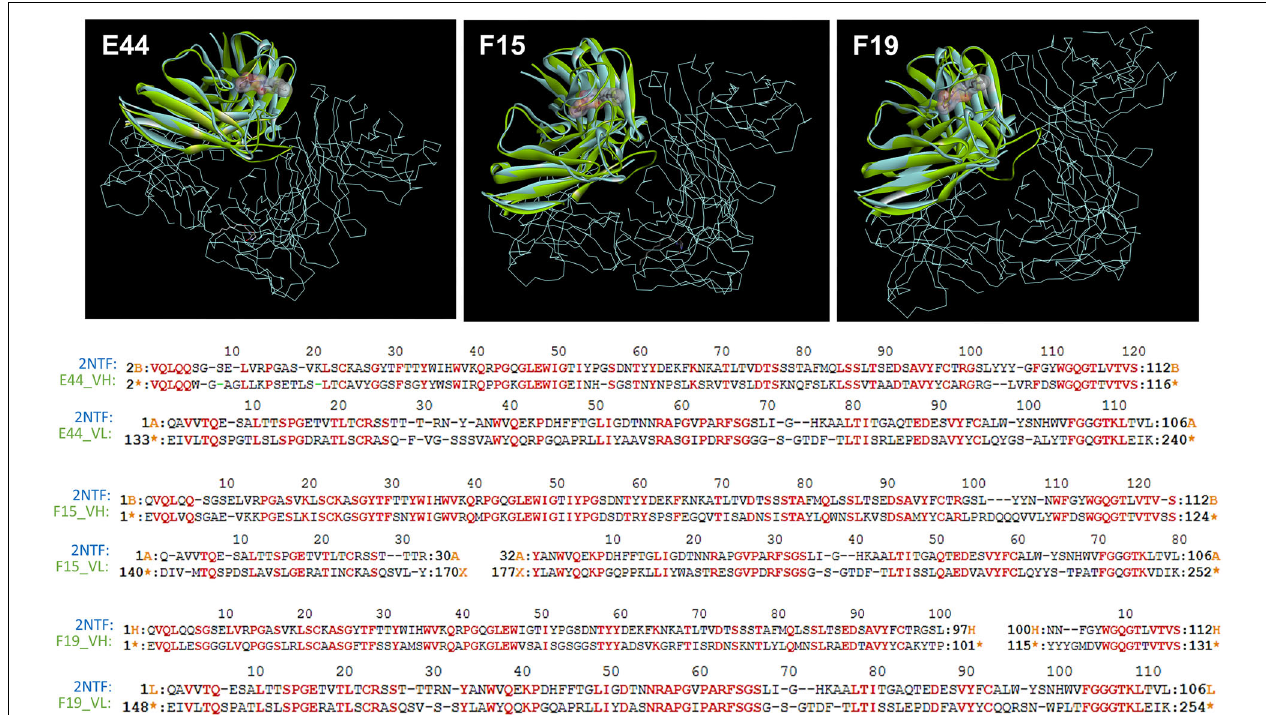
FIGURE 1 | The 3D complex of RS2-1G9 F(ab (cid:48) ) 2 fragment and N -Acyl- L -homoserine lactone analog (PDB:2NTF) was superimposed by the HuscFv-E44 (left), HuscFv-F15 (middle), and HuscFv-F19 (right) using CLICK: http://mspc.bii.a-star.edu.sg/click (Upper panel) . One antigen-binding site of the mAb RS2-1G9 F(ab (cid:48) ) 2 fragment (VH and VL domains, shown in blue) was superimposed by the HuscFvs (green). The trace illustration is the remaining portion of the RS2-1G9 F(ab (cid:48) ) 2 . Lower panel , the superimposed amino acids of the RS2-1G9 antigen-binding site (2NTF) and the VH and VL of HuscFv-E44, HuscFv-F15, and HuscFv-F19, are shown in red alphabets.